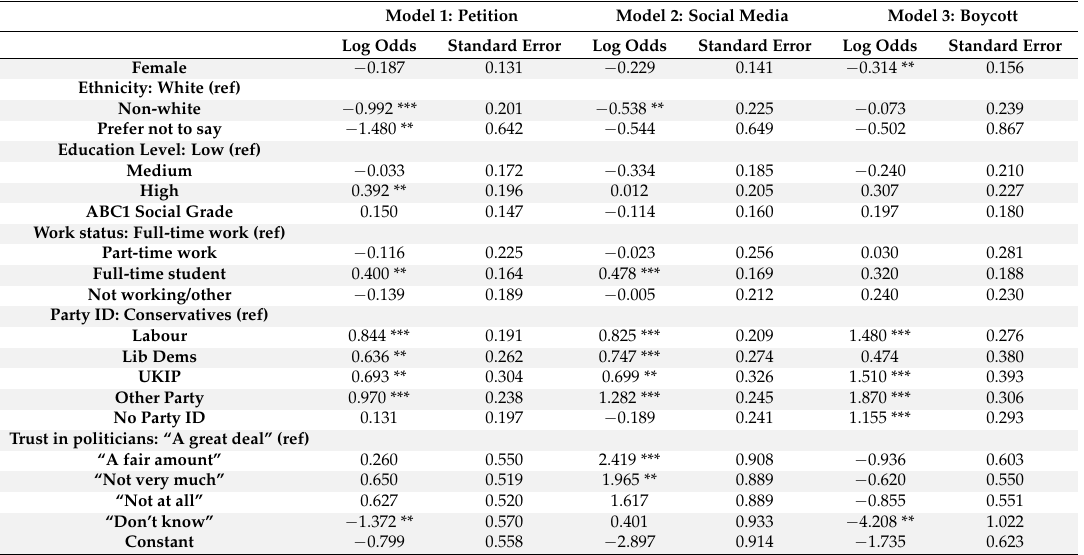
Table 2. Three-model table for non-electoral youth political participation (binary logistic